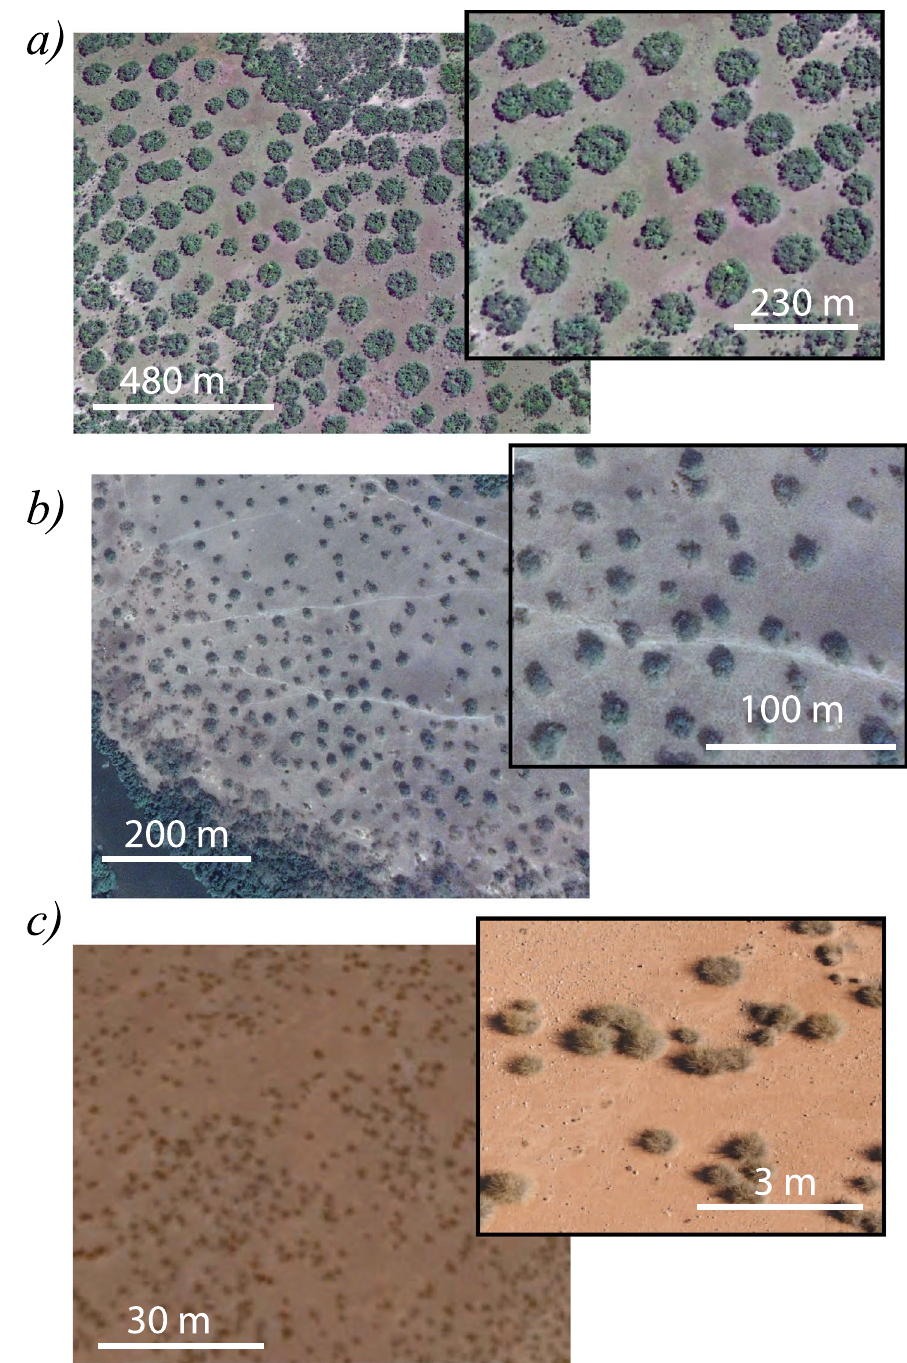
Figure 1. Satellite snapshots of self-organisation of localised patches obtained using Google Earth Pro. ( a ) Zambia, Southern Africa ( ′ . ″  13 46 49 07 S, ′ . ″  25 16 56 97 E). ( b ) Ivory Coast, West Africa ( ′ . ″  7 14 53 01 N, ′ . ″  6 06 27 83 W). ( c ) Morocco, North West Africa ( ′ . ″  33 06 24 02 N, ′ . ″  4 22 01 90 W). The insets account for enlarged snapshots of the respective